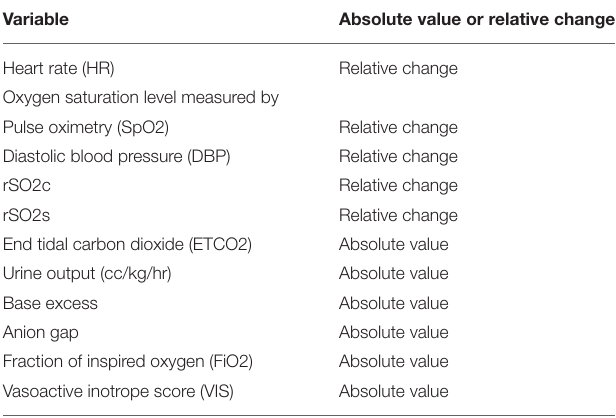
TABLE 2 | Clinical features: absolute value vs. relative change from